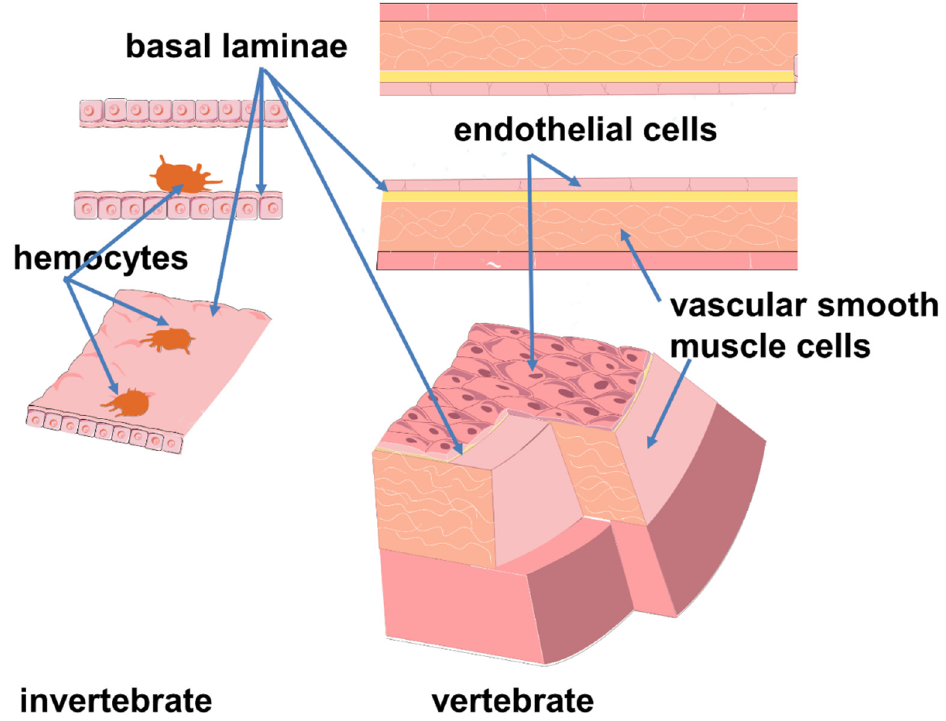
Figure 2. A model of invertebrate and vertebrate vessels.